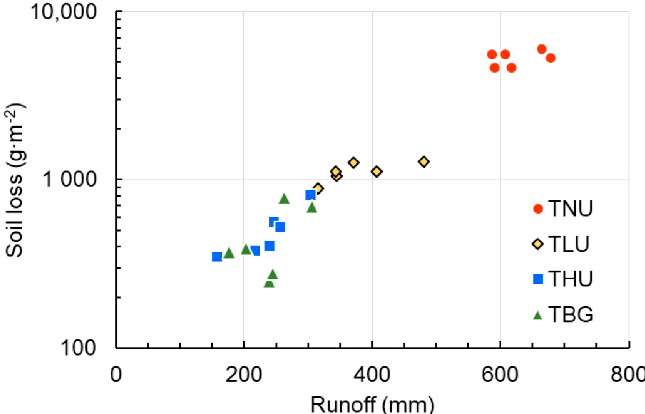
Figure 6. Surface runoff (mm) and soil loss (g.m − 2 , logarithmic scale) measured from 4 June to 15 October 2017, in the four treatments with six replicates in Ban Kokngew, Luang Prabang Province, Lao People’s Democratic Republic. TNU: teak with no understory; TLU: teak with low density of understory; THU: teak with high density of understory; TBG: teak with broom grass.